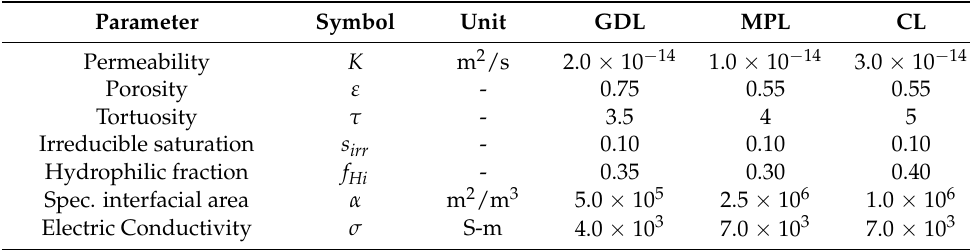
Table 4. Porous medium parameters for the base case.